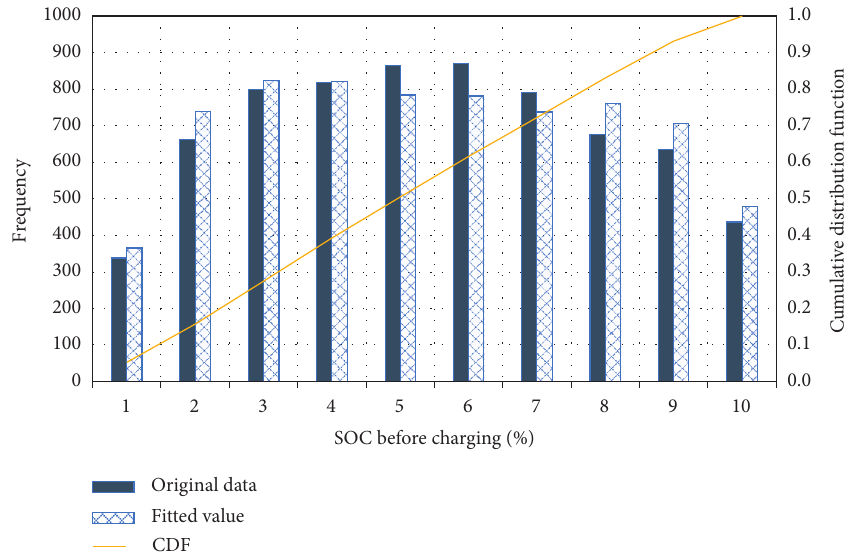
Figure 5: The distribution of SOC before